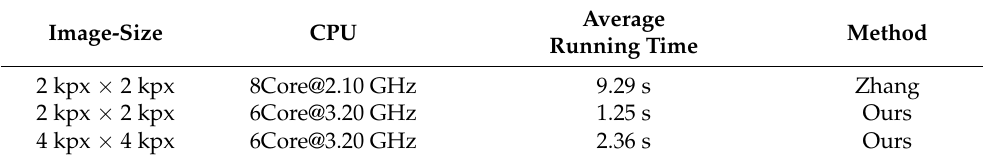
Table 2. Comparison of average execution time.